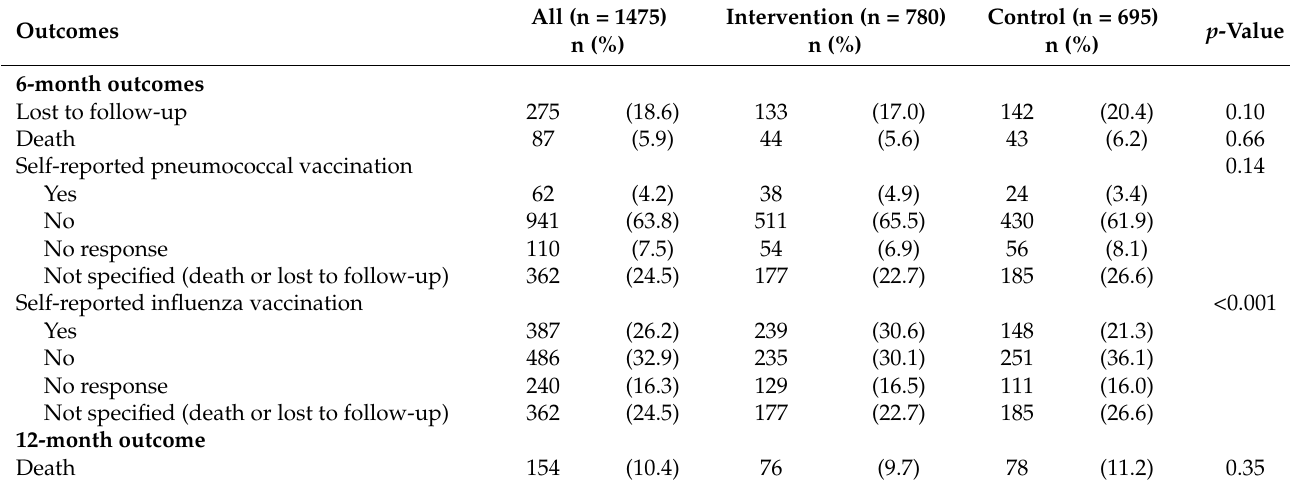
Table 2. Comparison of 6-month and 12-month outcomes between study arms; IMPROVED trial.